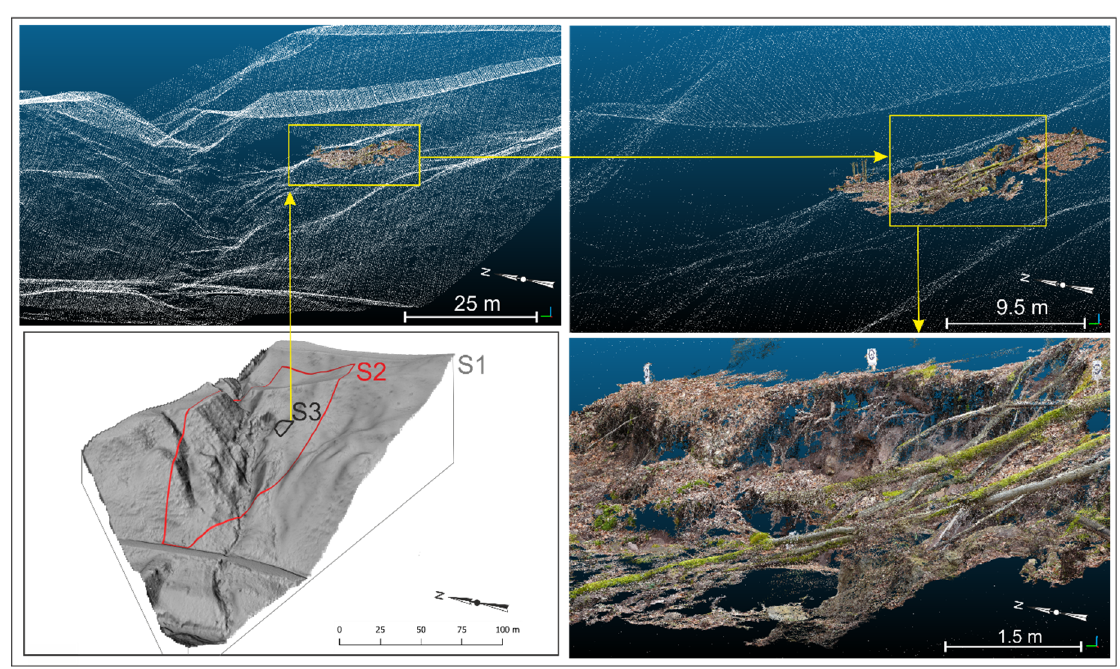
Figure 7. The investigated minor scarp documented in merged point clouds from the LiDAR data (Spring 2011) and CRP SfM data (Spring 2017). Point clouds were merged in CloudCompare v2.9.1.